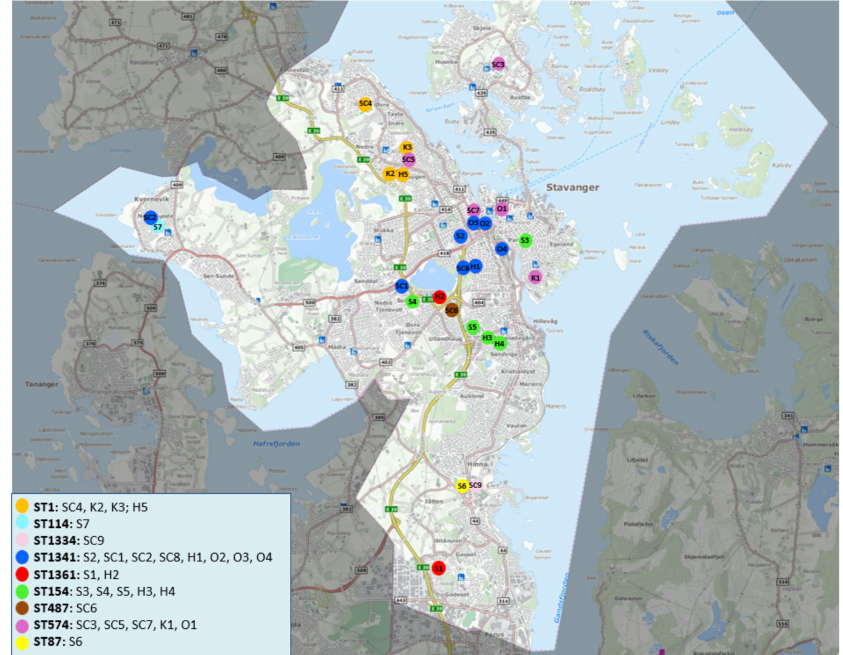
Figure 2. Geographical distribution of L. pneumophila STs in shower systems in the Stavanger munici- pality in the initial round. Each dot represents a municipal shower system containing L. pneumophila . Each ST is indicated with a distinct colour. The building code is the same as presented in Table 2, the capital letters represent the building type (SC = Sports Complexes, S = Schools, H = Nursing homes, K = Kindergarten, and O = Others) and the numbers represent the specific system. The highlighted section indicates the project